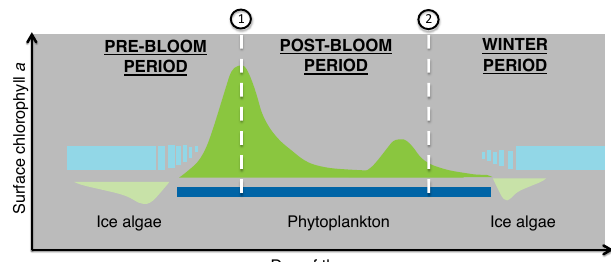
Ice algae ! Algue&de&glace&Algue&de&glace&